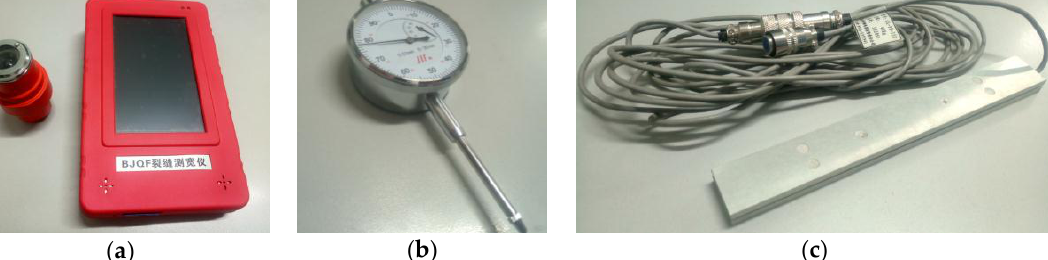
Figure 5. Experimental monitoring system: ( a ) Fracture width gauge; ( b ) Dial indicator; ( c ) Force test sensor.